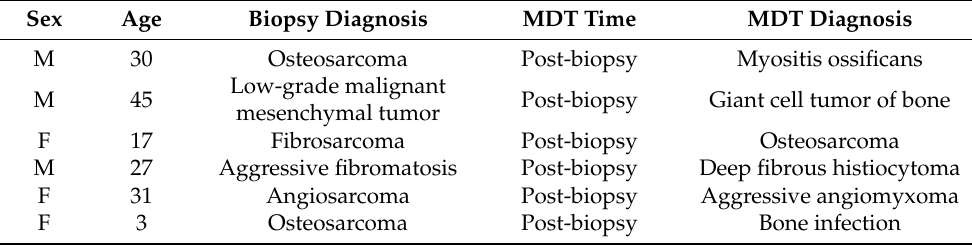
Figure 2. ( A ) The sex distribution of patients discussed by the MDT in 2018–2021; ( B ) The age distribution of patients discussed by the MDT in 2018–2021; ( C ) Topics discussed by the MDT in 2018–2021; ( D ) Distribution of malignant and non-malignant diseases among 269 patients. Table 2. The diagnosis corrected in six cases during MDT discussion after a biopsy.